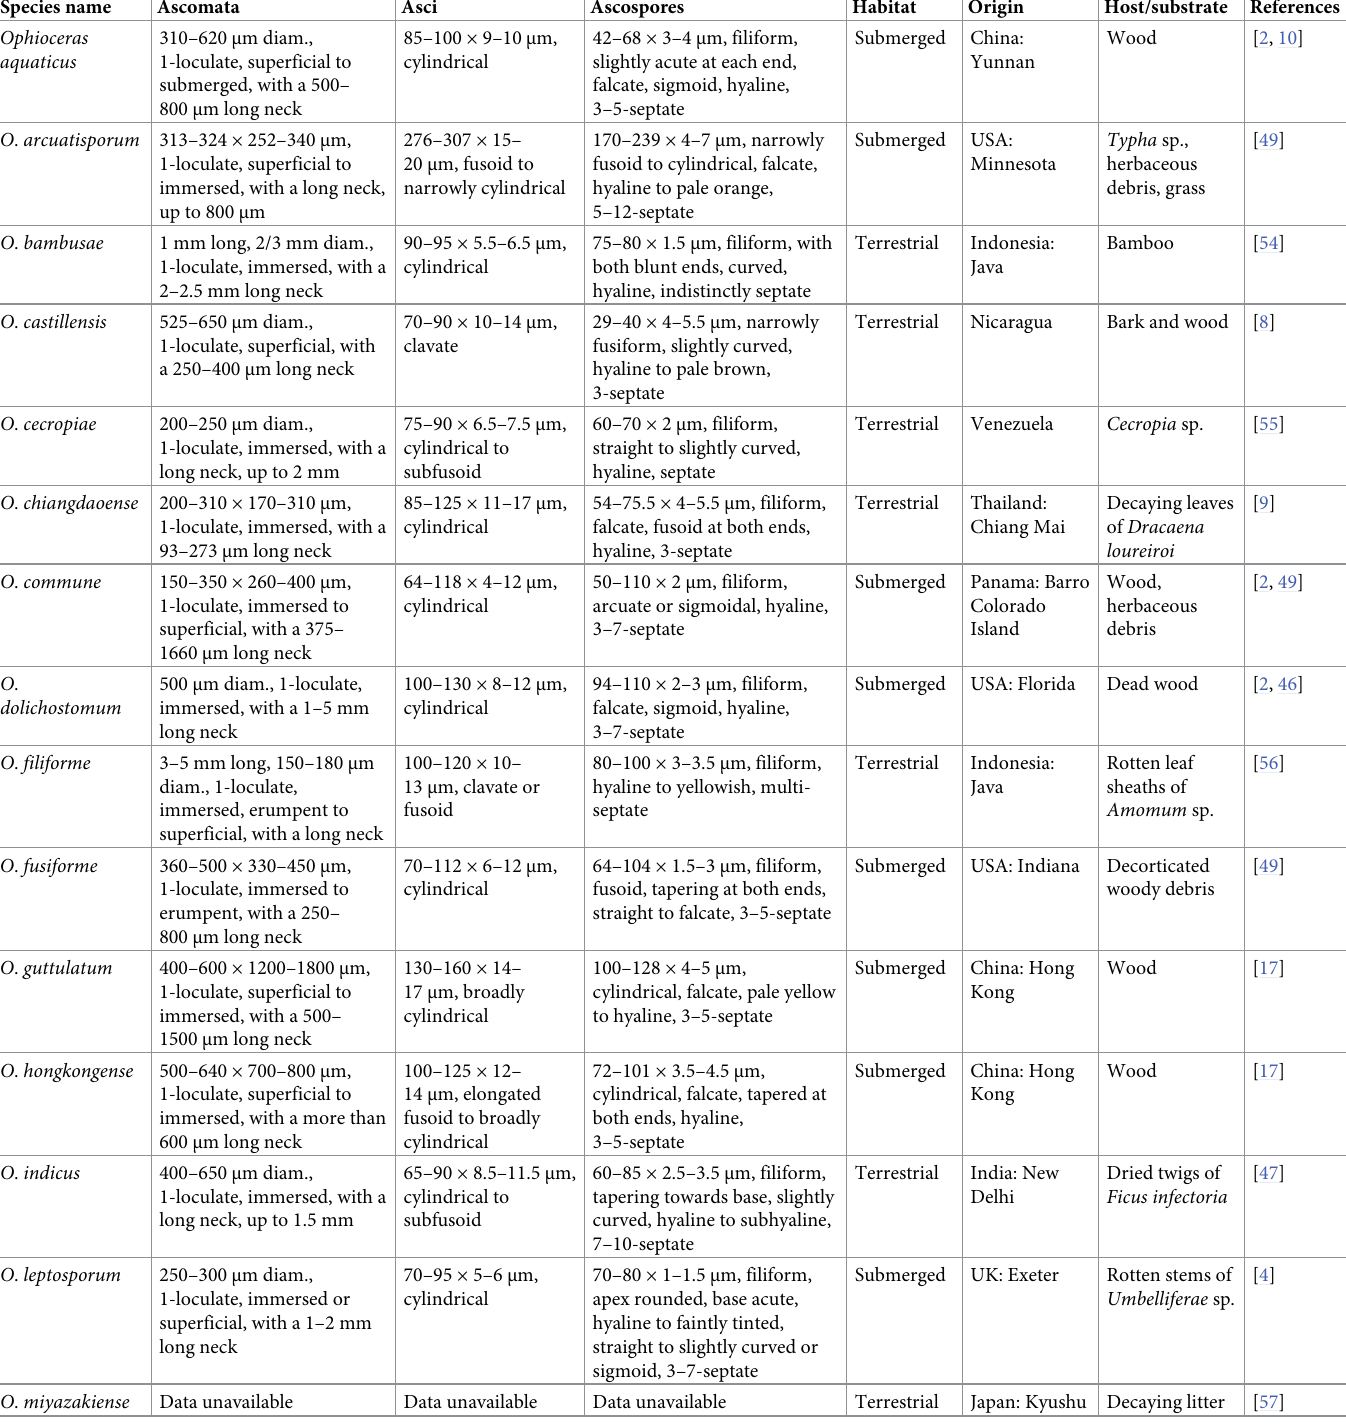
Table 2. Synopsis of Ophioceras